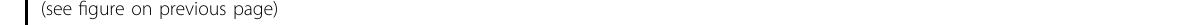
Fig. 7 Ligand – receptor-based interaction between tumor and immune cells. a Heatmap of the number of signi fi cant ligand – receptor interactions between cell types in the scRNA-seq data. b The interaction network between the tumor cell and other cell types. The direction of the arrow indicates the cell type expressing the receptor. The wider the edge or larger the dot is, the greater the number of interactions. c Heatmap of the number of signi fi cant interactions mediated by tumor cells as ligand-expressing and receptor-expressing cells. d Dot plots showing the mean interaction strength for selected ligand – receptor pairs between tumor cells and TAM clusters. The left and right plots show that the ligand is expressed in the tumor cells and TAM clusters, respectively. Dot size indicates the P value, colored by the average expression level of interacting molecule 1 in cluster 1 and interacting molecule 2 in cluster 2. e The Kaplan – Meier overall survival curves of TCGA-KIRC patients grouped by the averaged expression of RPS19 and C5AR1 (with the median value as the threshold). HR, hazard ratio. f Dot plots showing the mean interaction strength for selected ligand – receptor pairs between tumor cells and three lymphoid subsets. The left and right plots show that the ligand is expressed in the tumor cells and lymphoid subsets, respectively. Dot size indicates the P value, colored by the average expression level of interacting molecule 1 in cluster 1 and interacting molecule 2 in cluster 2. g Kaplan – Meier overall survival curves of TCGA-KIRC patients grouped by the averaged expression of LTB and LTBR (with the median value as the